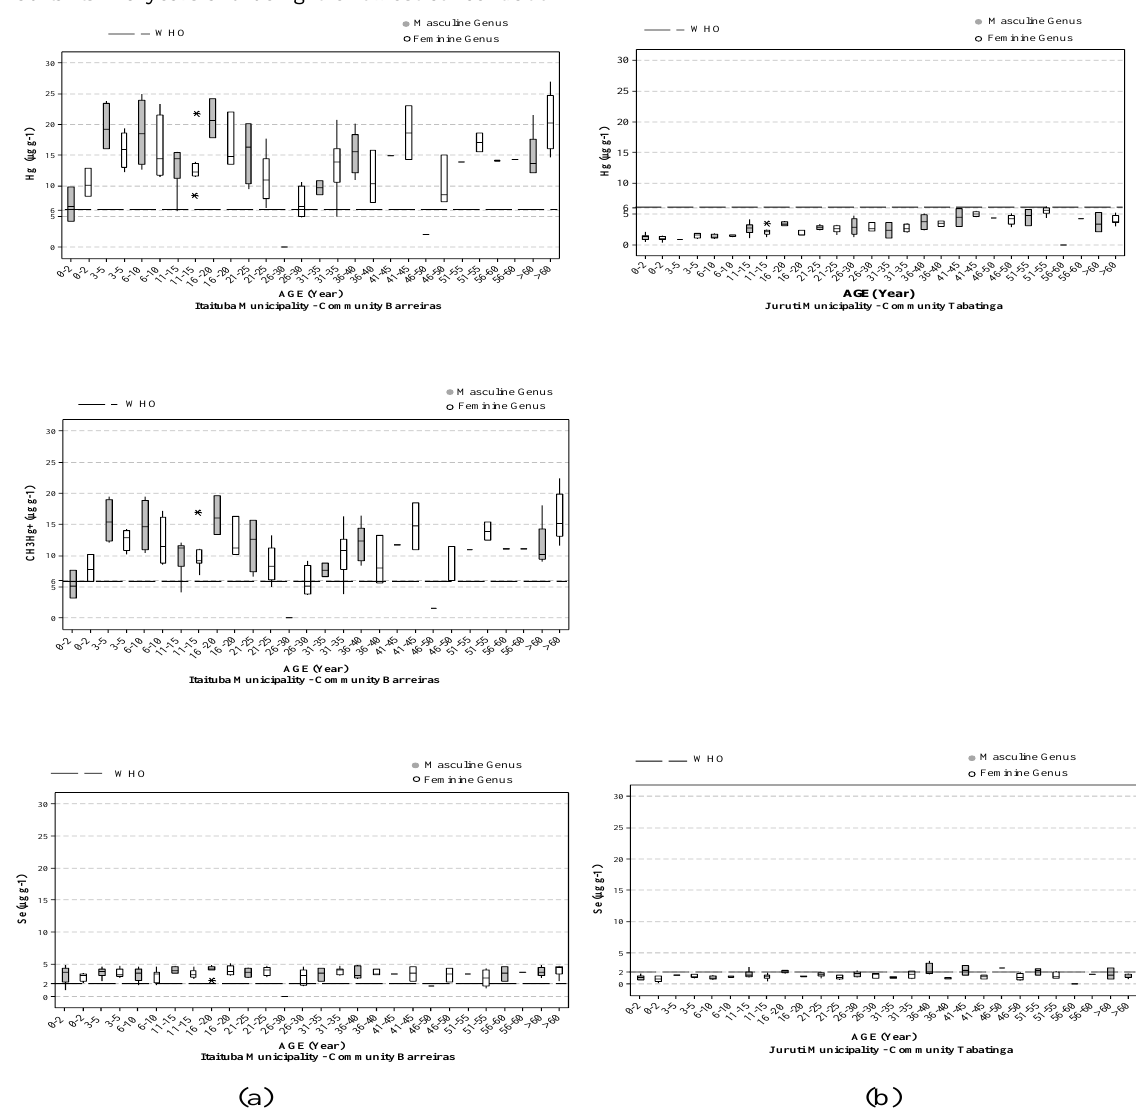
Figure 2: Hg, CH 3 Hg + and Se concentration in hair samples of riverine inhabitants belonging to (a) Itaituba municipality - Barreiras Fig. 2. Hg, CH 3 Hg + and Se concentration in hair samples of riverine inhabitants community (area impacted by gold mining underground) and (b) Juruti municipality - Tabatinga community (area without mining impact) (masculine and feminine genus), belonging to the Tapajós basin, Pará state (Amazon,